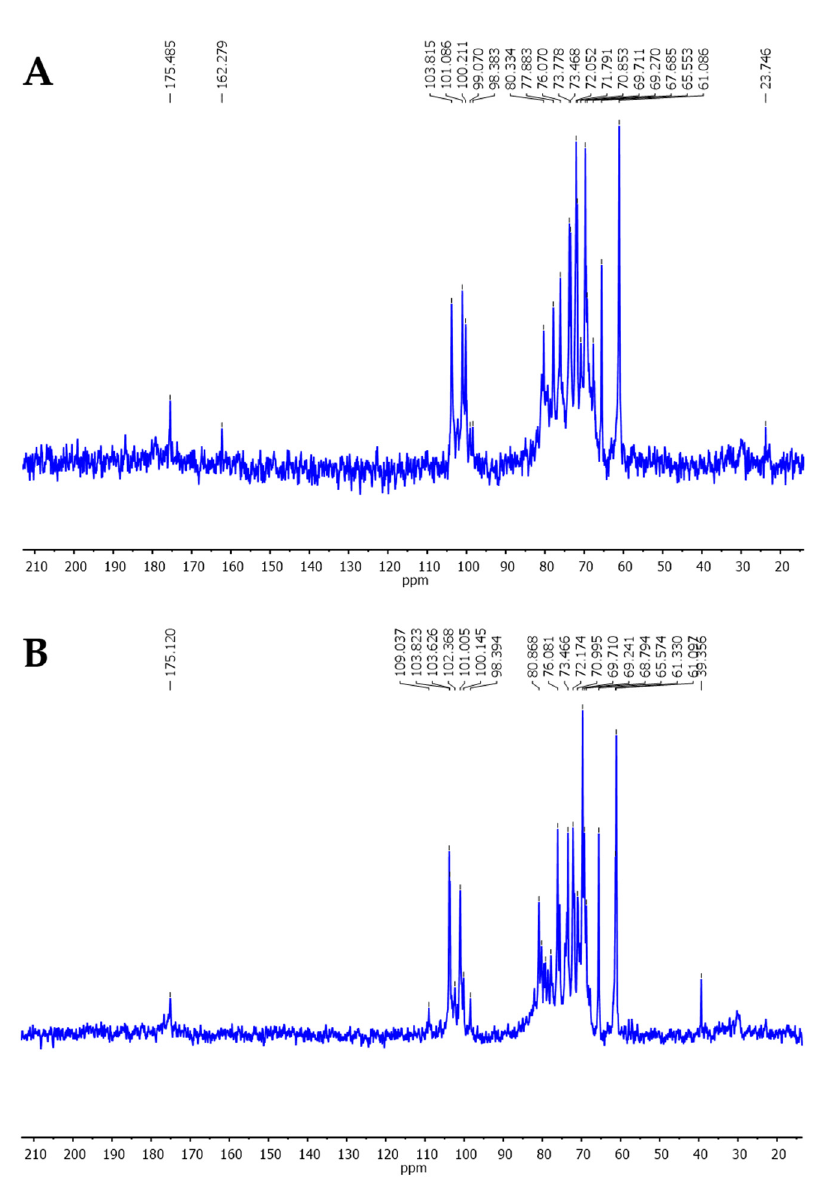
Figure 3. 13 C-NMR spectra at 300 MHz of ( A ) JSP and ( B ) JDP fractions. The analyses were recorded at 40 g/L in D 2 O solution at 60 °C.